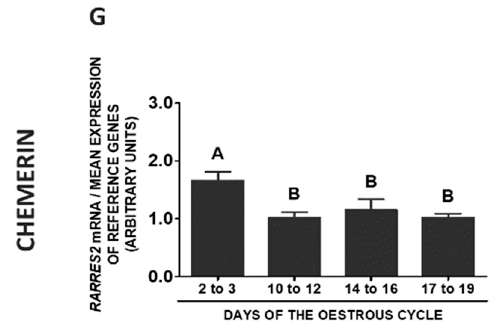
Figure 8. Chemerin system expression in the porcine preoptic area (POA) during the oestrous cycle. Gene and protein expression of chemokine-like receptor 1 (CMKLR1; A and B ), G protein-coupled receptor 1 (GPR1; C and D ) and C-C motif chemokine receptor-like 2 (CCRL2; E and F ), as well as chemerin ( RARRES2 ) mRNA content ( G ) in the porcine POA on days: 2 to 3, 10 to 12, 14 to 16 and 17 to 19 of the oestrous cycle. Gene expression was determined by qPCR. Protein expression was determined by Western blotting; upper panels: representative immunoblots; lower panels: densitometric analysis of CMKLR1/GPR1/CCRL2 proteins relative to actin protein. Representative actin blots are identical for all chemerin receptors though proteins have been analysed on different gels. Results are presented as means ± SEM ( n = 5). Bars with different superscripts differ (one-way ANOVA at p < 0.05 followed by Tuckey post-hoc test at p < 0.05).